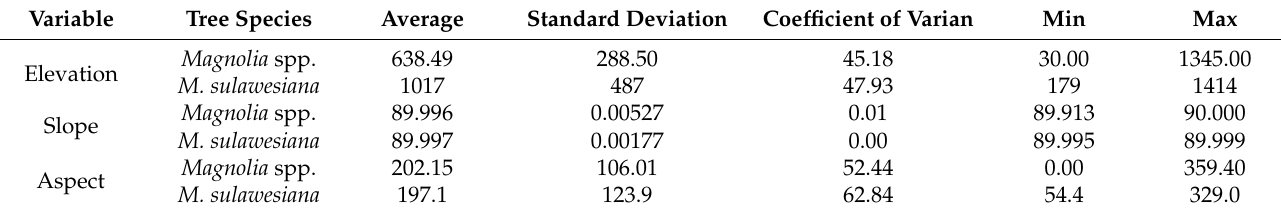
Table 6. Statistical descriptions for topography